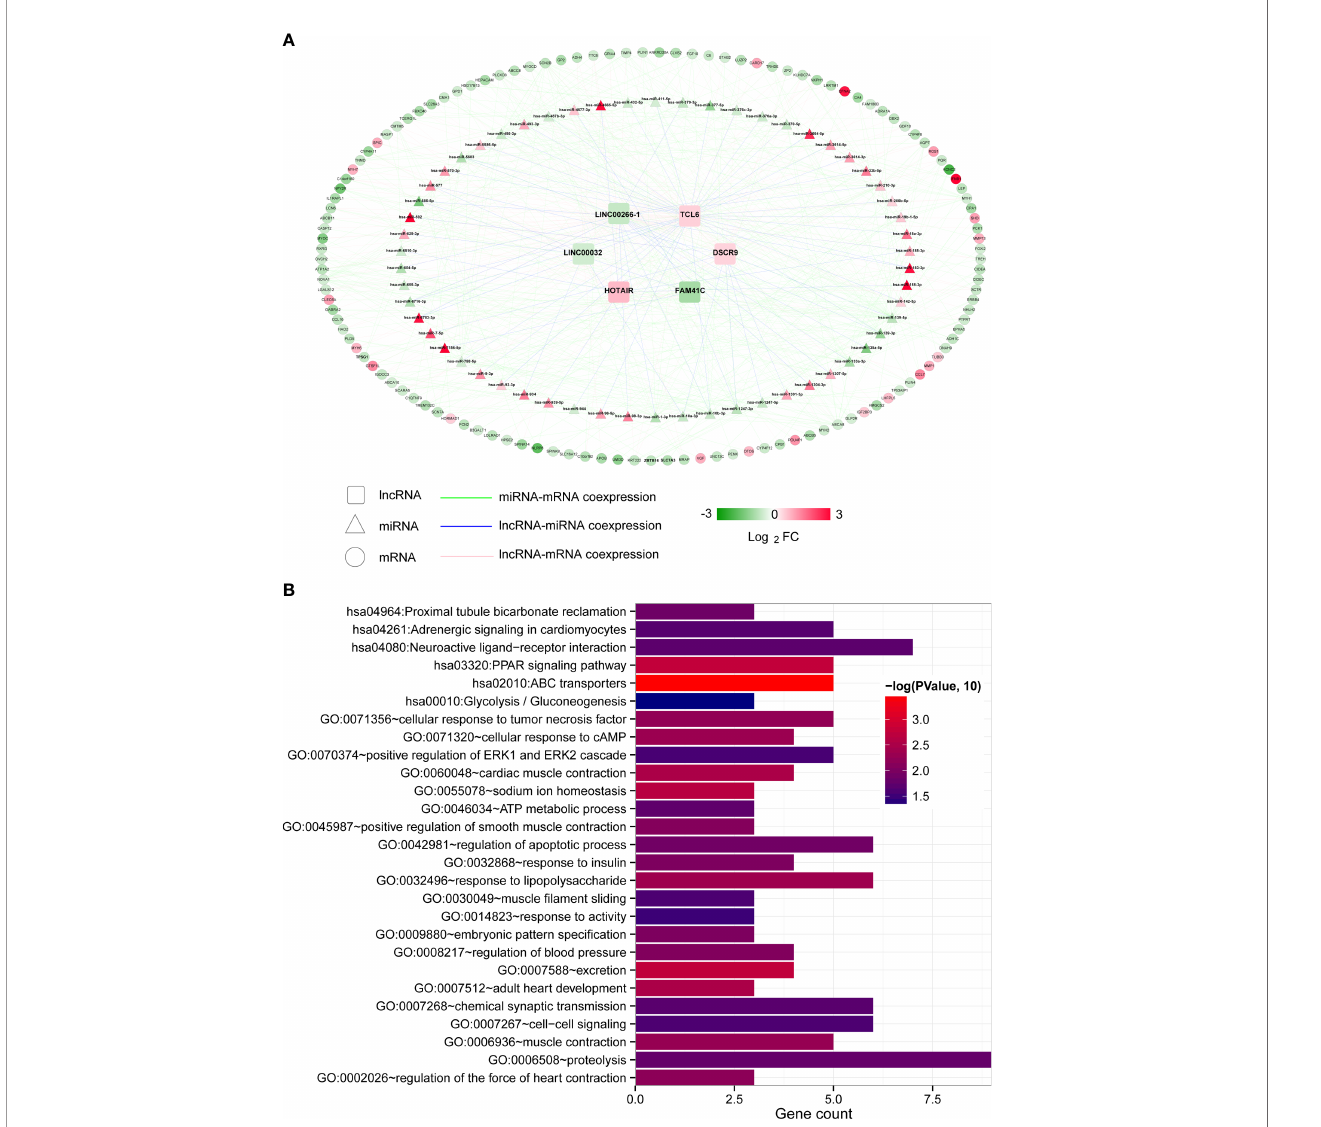
FIGURE 3 | Coexpression ceRNA regulatory network. (A) The coexpression relationships among lncRNAs, miRNAs and mRNAs. The colour change from green to red indicates a change from low to high. (B) Bar diagram of the GO biological processes and KEGG signalling pathways signi fi cantly correlated with mRNAs in the ceRNA network. The horizontal axis depicts the number of genes. The vertical axis shows the entry names. Entries closer to a red colour are more signi fi